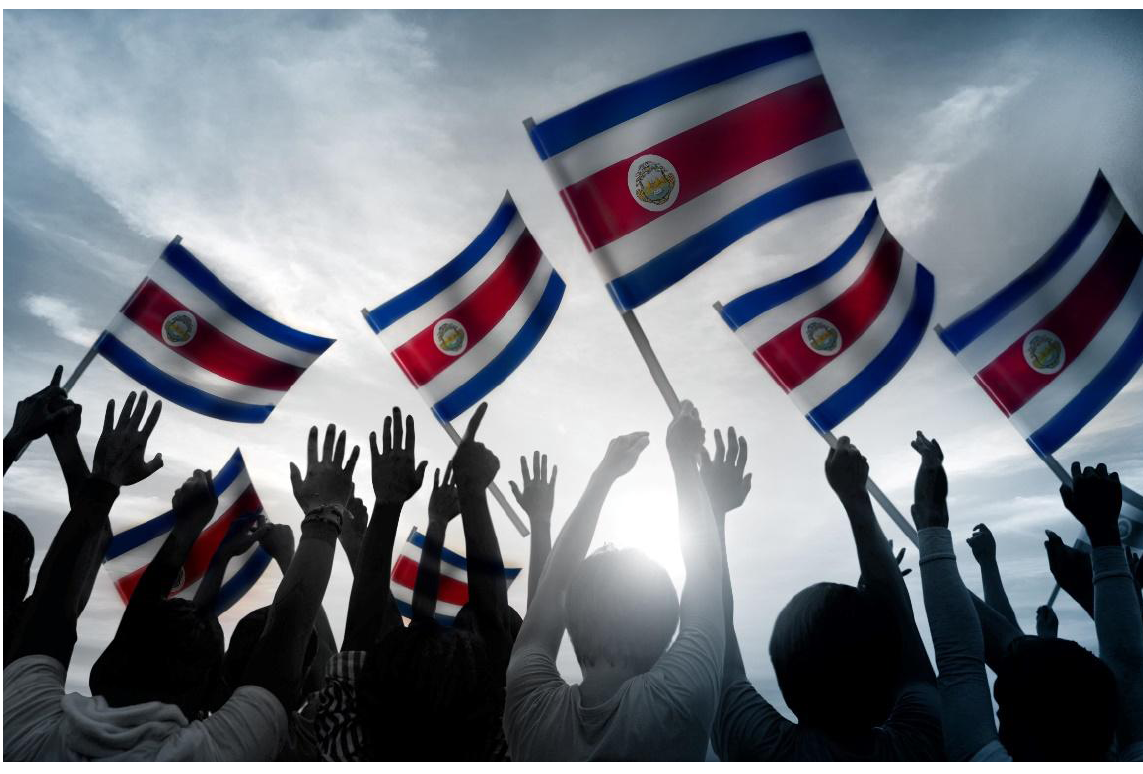
FIG. 3 Hands with flags